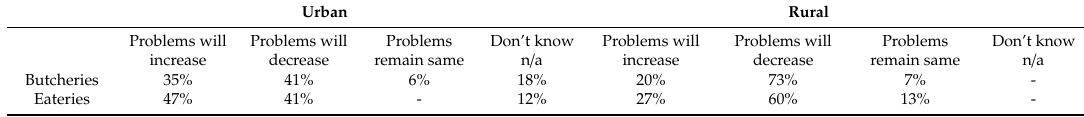
Table 2. Expectations regarding major problems with meat safety in the future 1)